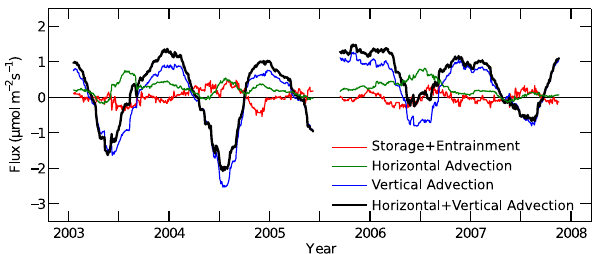
Fig. 3. Contribution of mixed-layer budget terms to the surface flux at SGP, calculated from 90-day running averages using 60-m tower and aircraft mixing ratios, and decomposed into horizontal advection (green), vertical advection (blue), storage plus entrain- ment (red) and the sum of all terms (thick black).